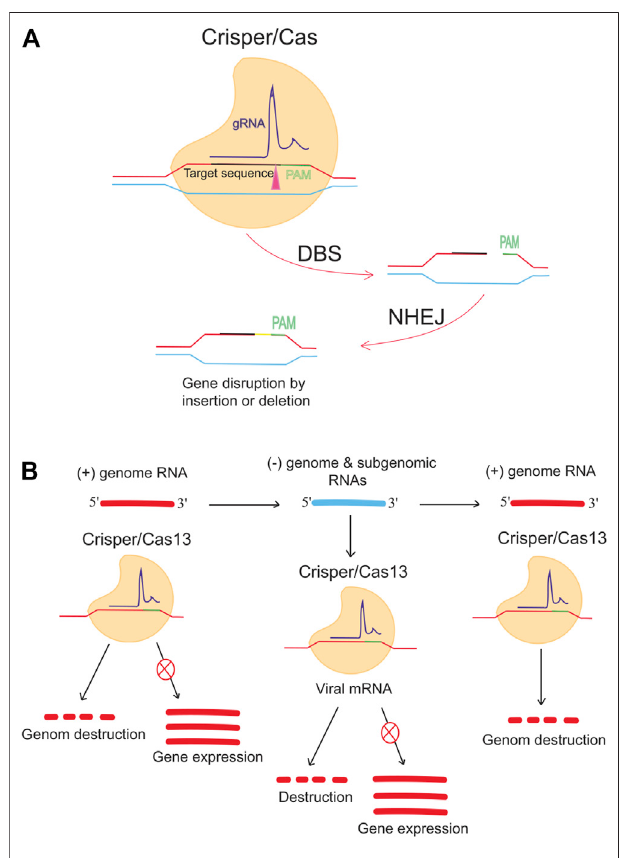
FIGURE 3 | Anti-COVID-19 genome editing was performed using the Crisper/Cassystem andPAC-MAC function. (A) Amutationinthetarget gene is caused by the CRISPR/CAS9 system, which is supported by the NHEJ repair mechanism and causes a change in the gene. The gene expression is reduced or stopped depending on the target. (B) Cas13d can inhibit viral activity and replication. Cas13d targets and cleaves 100% of the positive sense RNA produced by